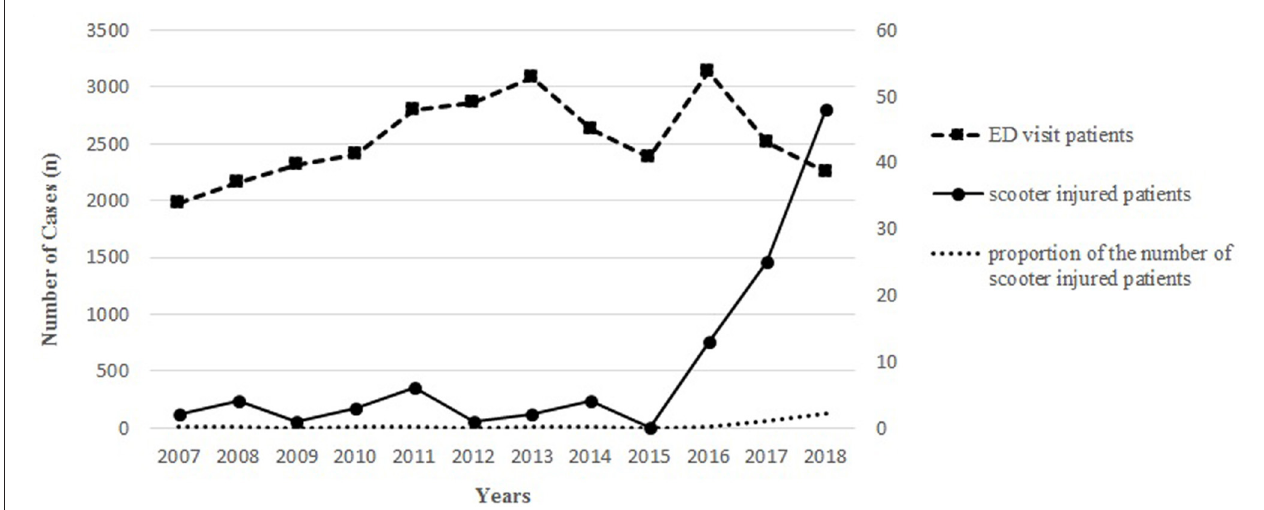
FIGURE 1 | Number of unpowered scooter-related injury and the total number of ED visits from 2007 to